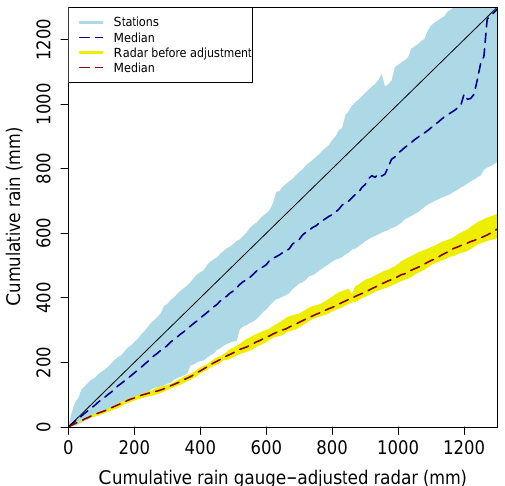
Figure 7. Double mass plots of station filtered rainfall measure- ments and real-time radar data with gauge-adjusted radar rainfall at the corresponding location in the period between December 2014 and March 2016. Only intervals where both radar and station con- tain measurements are taken into account. Colored regions indicate the range between double mass plot of stations with minimum and maximum steepness and dashed lines represent the median of the combined